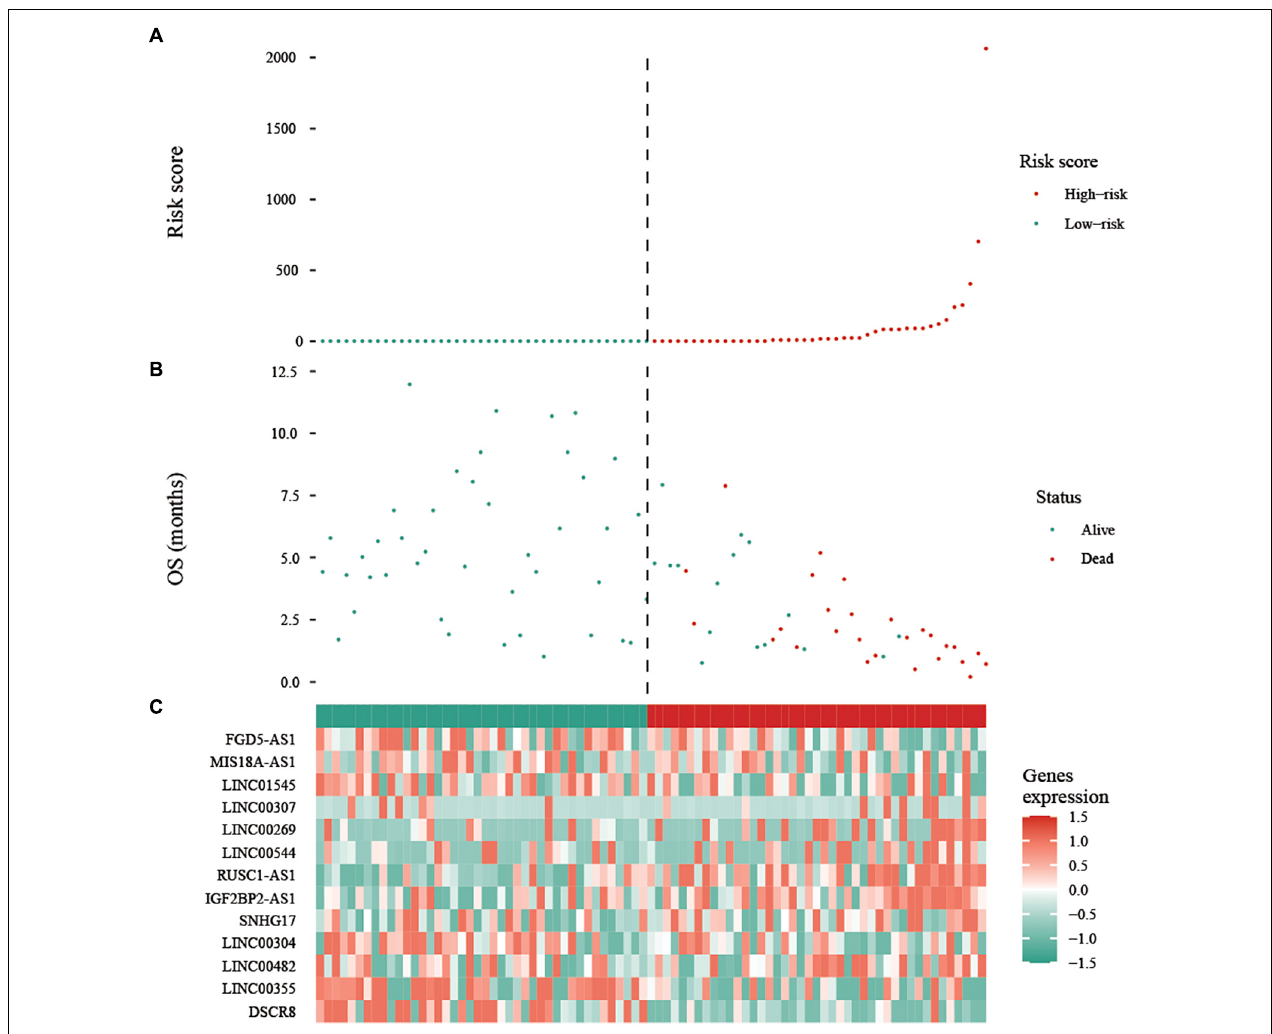
FIGURE 5 | Expression of the prognostic autophagy-related lncRNA signature. (A) Risk score distribution of patients in the prognostic autophagy-related lncRNA signature. Red means high risk, green means low risk. (B) Survival status scatter plots for patients in the prognostic autophagy-related lncRNA signature. The green and red dots represent survival and death, respectively. (C) Expression patterns of risk genes in the prognostic autophagy-related lncRNA signature. Red means high expression, green means low expression. OS: overall